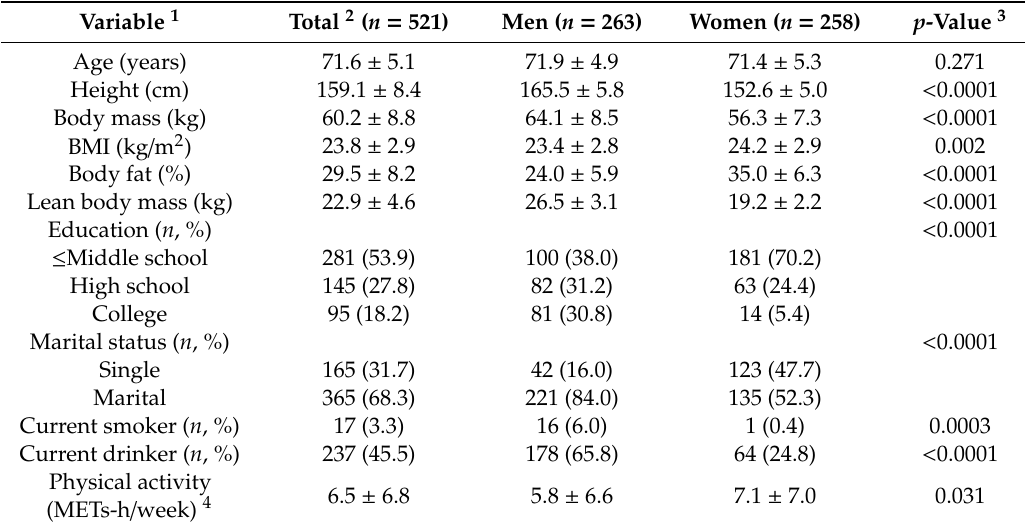
Table 1. General characteristics of the elderly